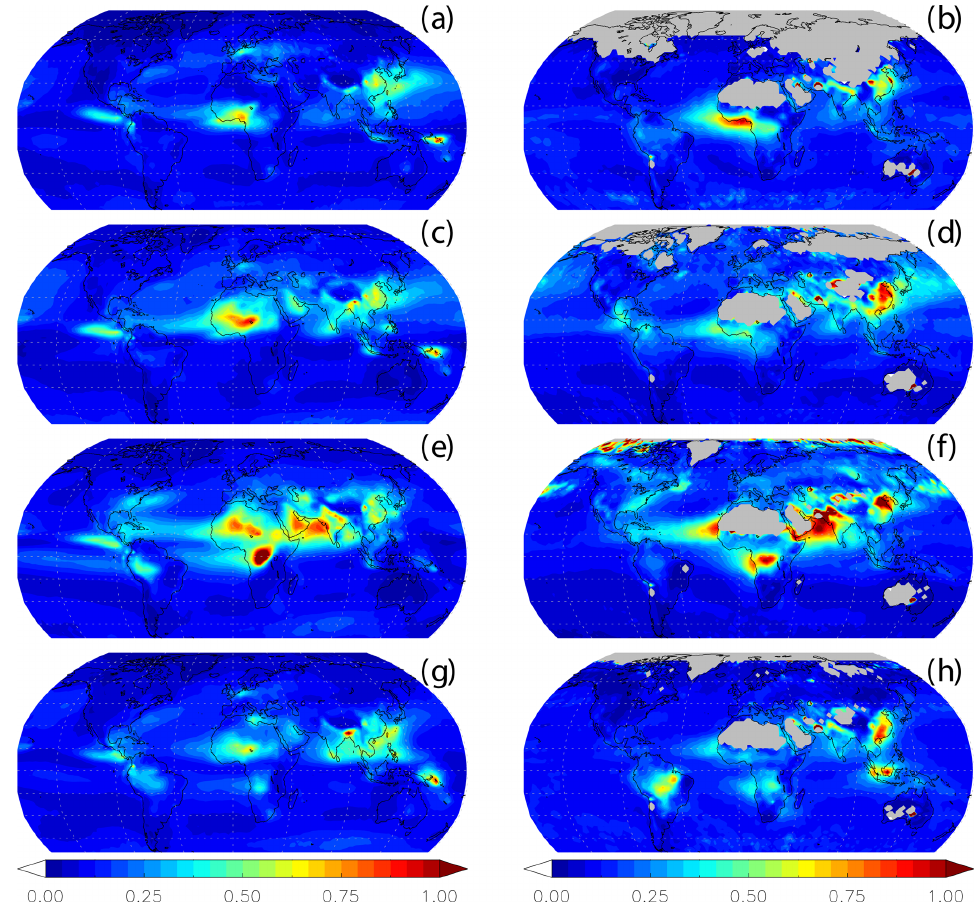
Figure 10. Monthly modeled clear-sky aerosol optical depth (AOD) simulated using pyrE fire emissions (left) and detected by Aqua MODIS (right): January (a, b) , April (c, d) , July (e, f) , and October (g, h) . Monthly-mean simulated AOD is based on an ensemble of 10 simulations, and climatologically monthly MODIS AOD is based on 2003–2007 data. Missing MODIS data are shaded in light